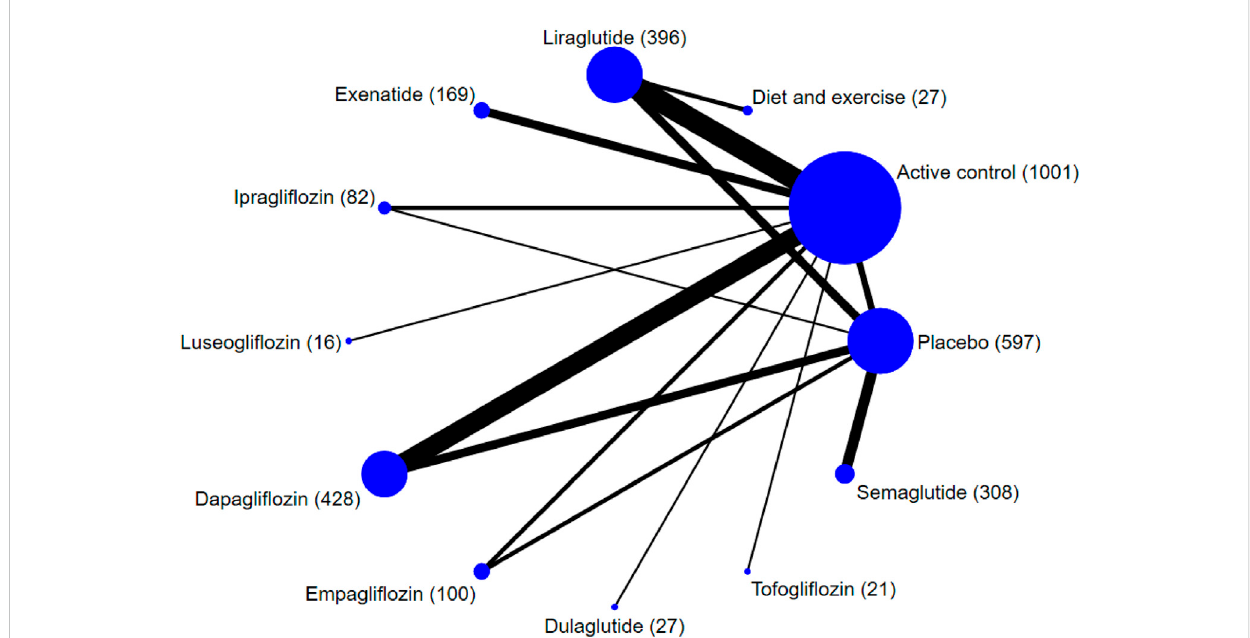
FIGURE 2 Networkplotoftrialsevaluatingtheeffectsofsodium-glucosecotransporterprotein-2inhibitorsandglucagon-likepeptide-1receptoragonistsfor patients withNAFLD. Networkshows thenumber ofparticipants assigned to eachtreatment class with thesize ofeach circleproportional tothenumber of randomly assigned participants inthe treatment comparisons (sample size for thespeci fi ctreatmentshown in brackets). Line thickness isproportional to the number of patients that contributed to the